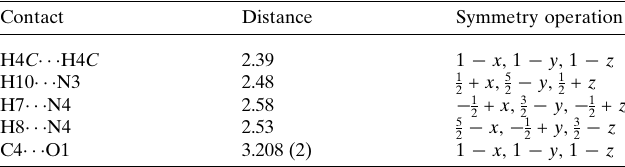
Table 2 Summary of short interatomic contacts (A˚ ) in (I).